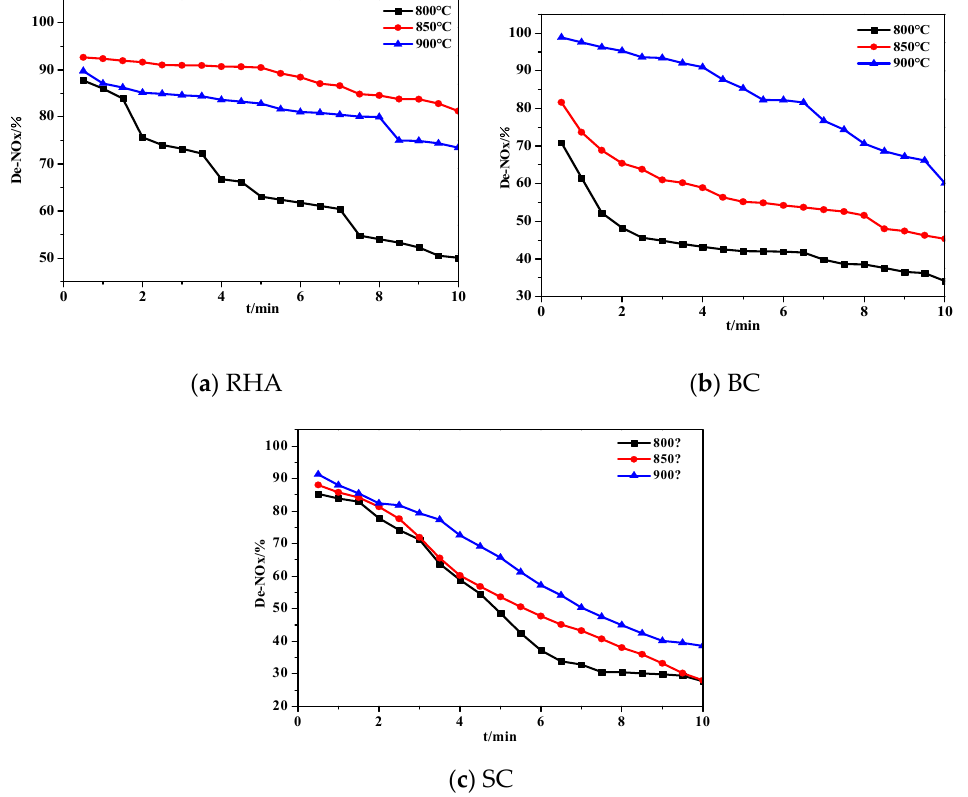
Figure 3. Effect of the reaction temperature on the denitration rate of ( a ) RHA, ( b ) BC, ( c ) SC.